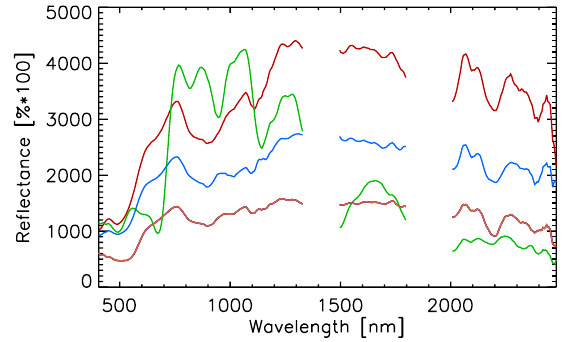
Figure 9. Spectra taken from 2nd example image. The green curve is a vegetation spectrum whereas the other spectra have been taken from within the open pit mine area. reproduced after DROACOR-H correction: the purple curve in Figure 4 corresponds to Hematite, the red curve to Goethite and the blue curve to a formation with high Kaolinite